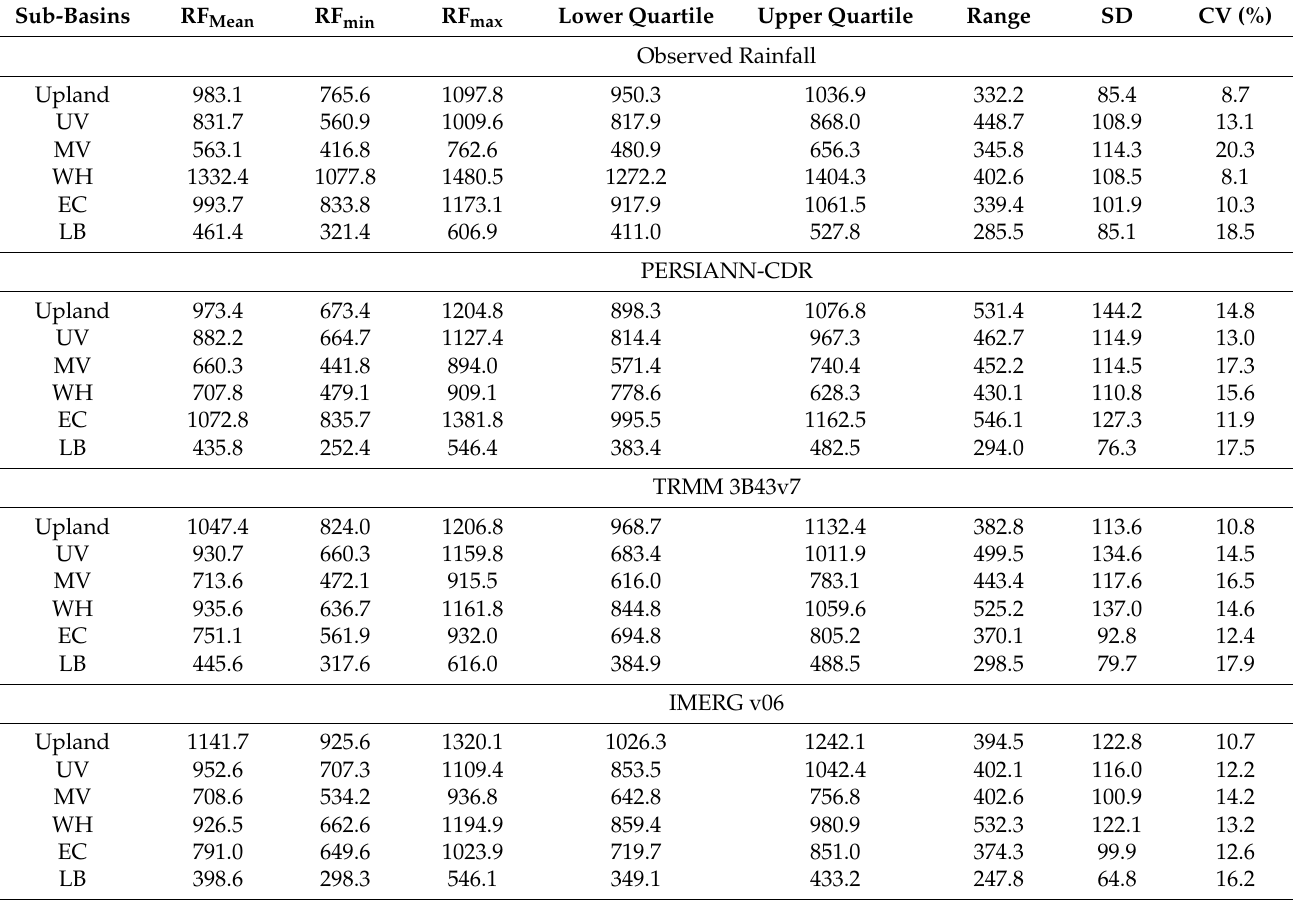
Table 2. Statistics of the annual area-weighted rainfall of the